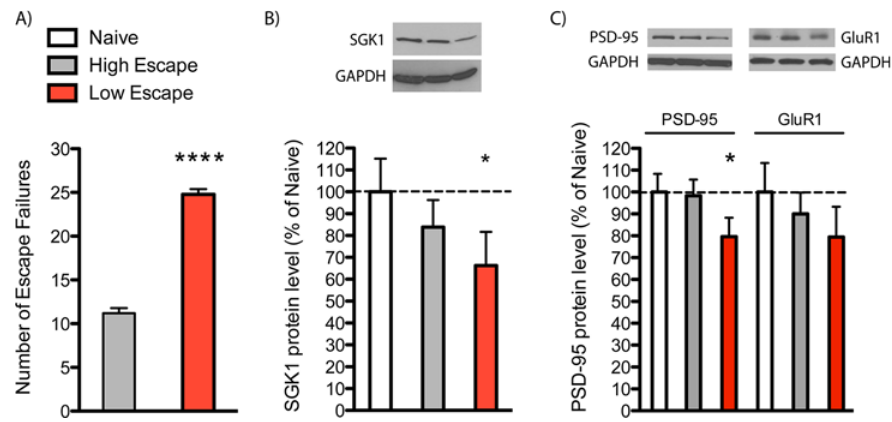
Fig 2. SGK1 expression is altered in learned helplessness. ( A) Rats were exposed to inescapable shock (day 1), tested in active avoidance (AA) (day 4), and then sacrificed (day 8) as indicated. Animals were separated into low- and high-escape groups according to their performance in AA test. Data are the mean ± SEM [t(12) = 14.39, Student ’ s t test, **** p < 0.0001]. (B) SGK1 and (C) PSD-95 protein levels in dissected PFC are decreased in the low-escape group. Data are mean ± SEM percent change over control group (naive, n = 5; high escape, n = 5; low escape, n = 9), One-way ANOVA with post hoc Bonferroni test: F (2,16) = 3.373 for SGK1 and F(2,16) = 3.704 for PSD-95, * p < 0.05. For underlying data, see S1 Data.